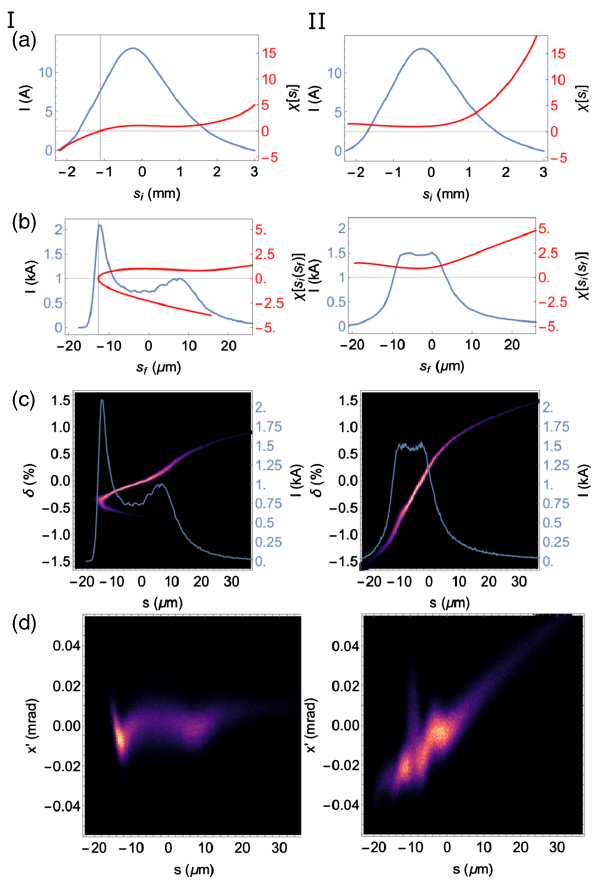
FIG. 2. (I) nominal LCLS-II beam (II) beam with current horns suppressed by single octupole showing: (a) Current profile (blue) and χ ð s i Þ (red) at linac entrance. (b) Current profile (blue) and ð s Þ(cid:3) (red) at BC2 exit. (c) Longitudinal phase space after χ ½ s i f BC2 with current profile (blue) for reference. (d) s vs x 0 phase space at BC2 exit. The bunch head is on the left in all plots.